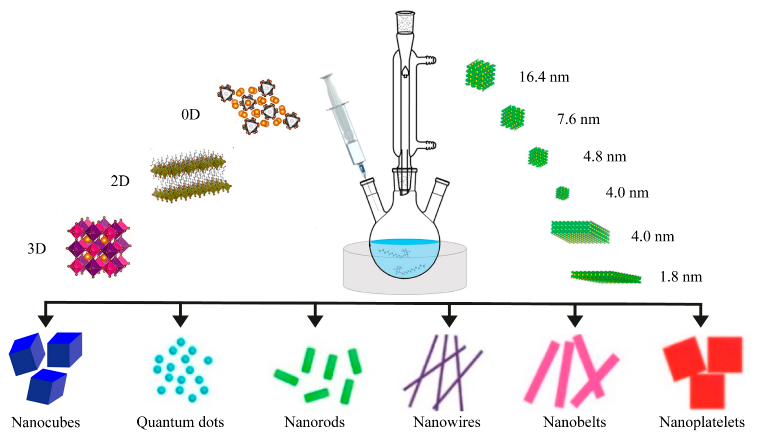
Figure 3. Scheme of the hot injection technique of colloidal synthesis. Reproduced from [23] © Amer- ican Chemical